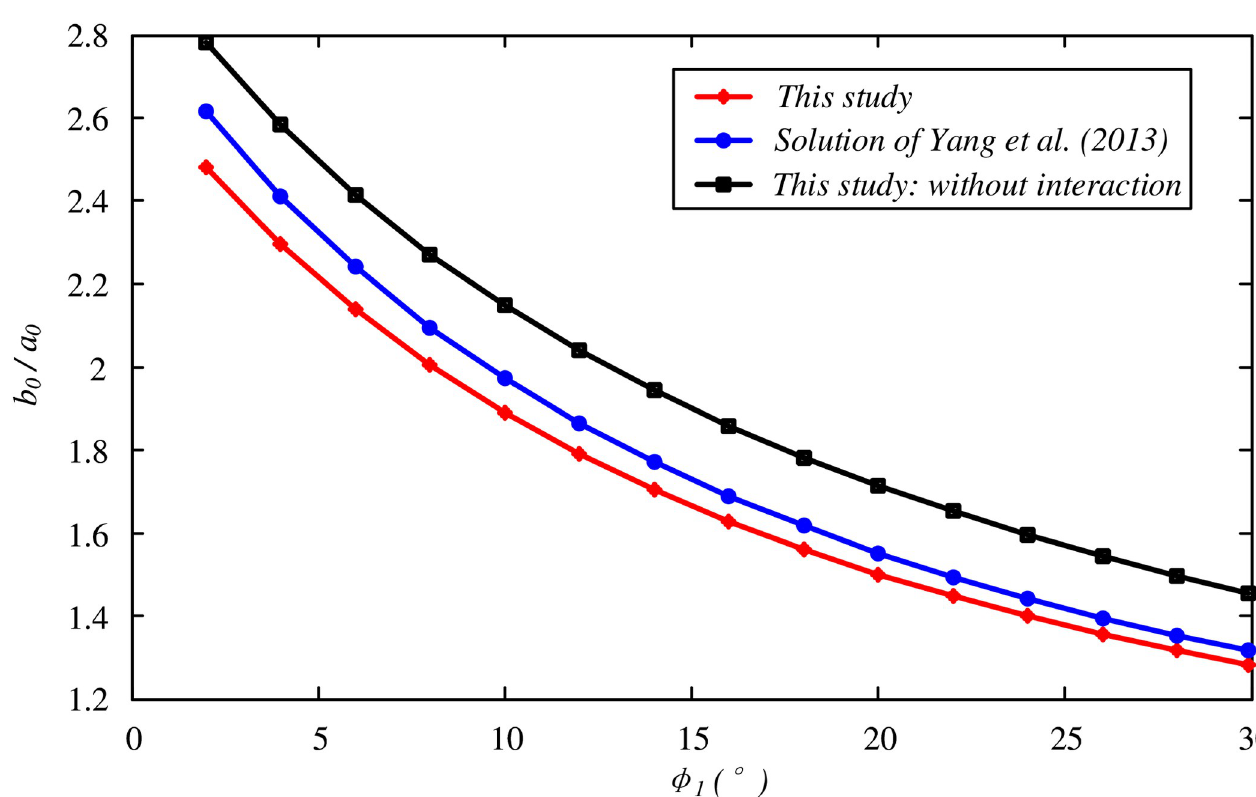
Fig 9. Comparisons of optimal thickness of the FSW with Yang’s solution and test without interaction effect.